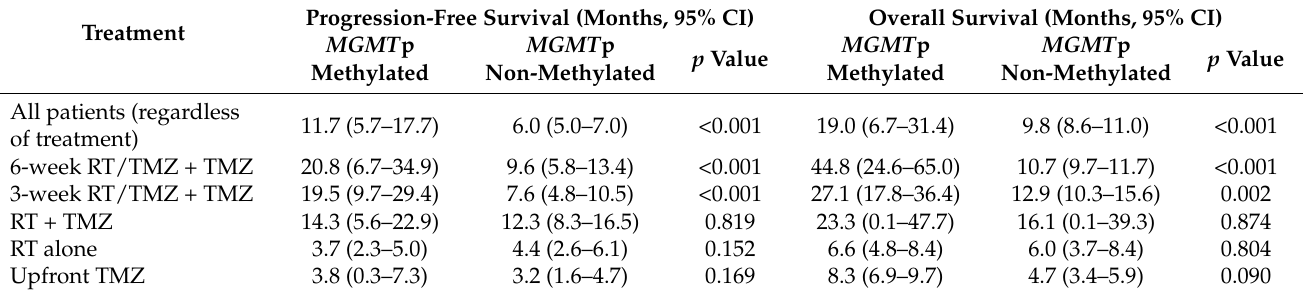
Table 8. Progression-free Survival and Overall Survival across Different Groups of Adjuvant Treat- ment According to MGMT p methylation status.